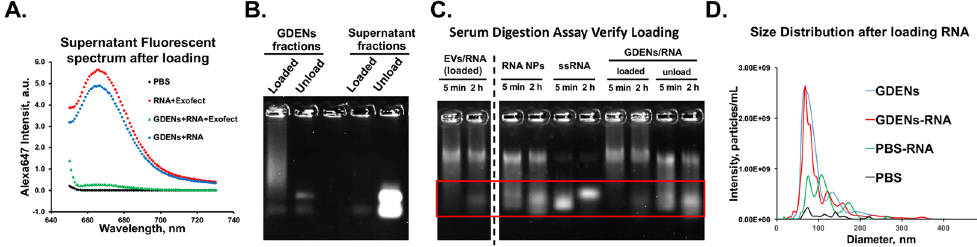
Figure 3. Loading RNA into GDENs. ( A ) Alexa 647 spectrum of the supernatant fraction after loading for loading efficiency estimation. ( B ) Equal amount of GDENs fraction and supernatant fraction were loaded in a 2% Synergel for electrophoresis and visualize by Alexa 647 channel. ( C ) 2% Synergel image showed GDENs loaded with 3WJ-Alexa 647 undergo 67% serum digestion compare to control groups. (All lanes displayed are in a same gel, full length gel in Supplementary Fig. S4). ( D ) NTA measurement of size distribution and particle quantification of RNA loaded GDENs compare to control groups.